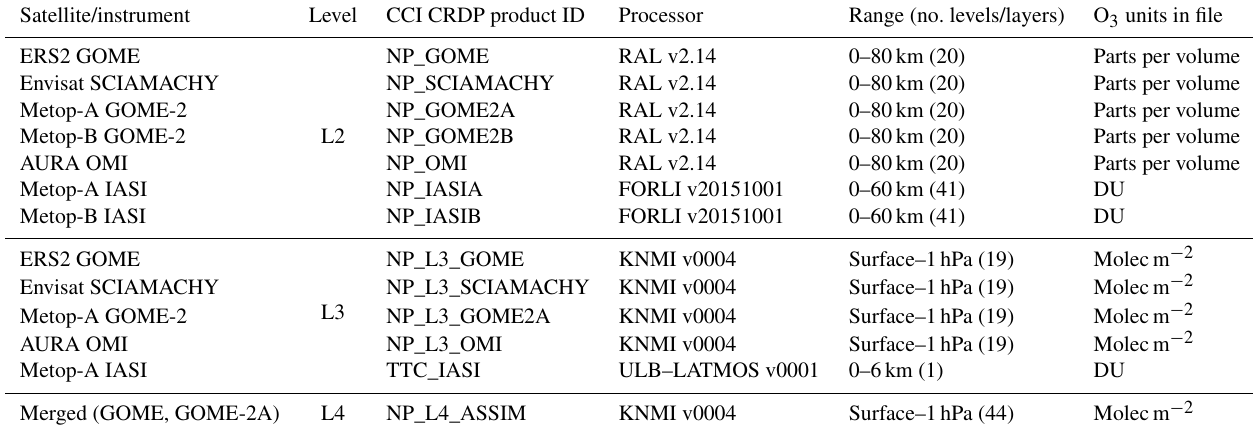
Table 1. Overview of the nadir ozone profile data products generated and delivered in the Ozone_cci CRDP. The products’ vertical range (with number of levels or layers between brackets) and original ozone units are added in the last two columns. Satellite/instrument